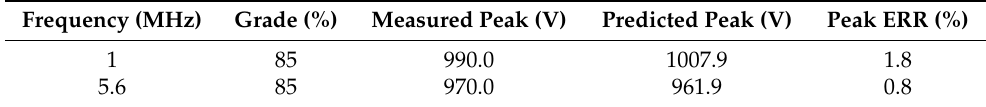
Table 2. The peak ERR between measurement and prediction of 1 MHz and 5.6 MHz.